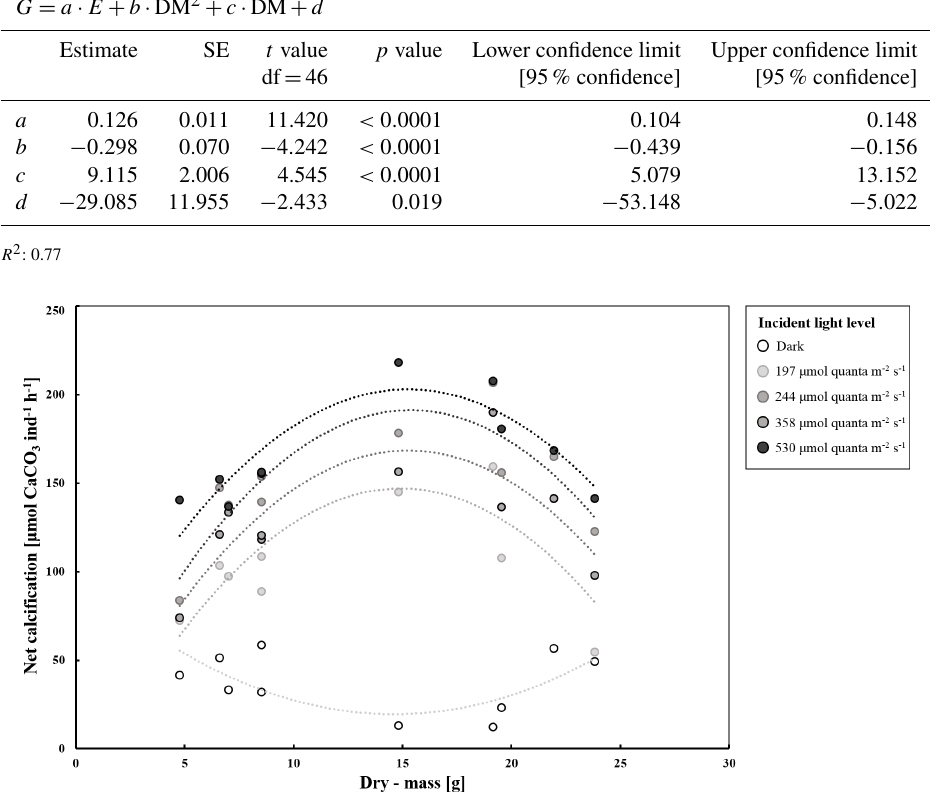
Figure 4. Net calcification (µmolCaCO 3 ind − 1 h − 1 ) ( n = 10) in T. maxima at four different incident light levels (197, 244, 358, and 531µmolphotonscm − 2 h − 1 ) and in the dark, plotted against tissue dry mass (g). Data are shown with polynomial trend lines.